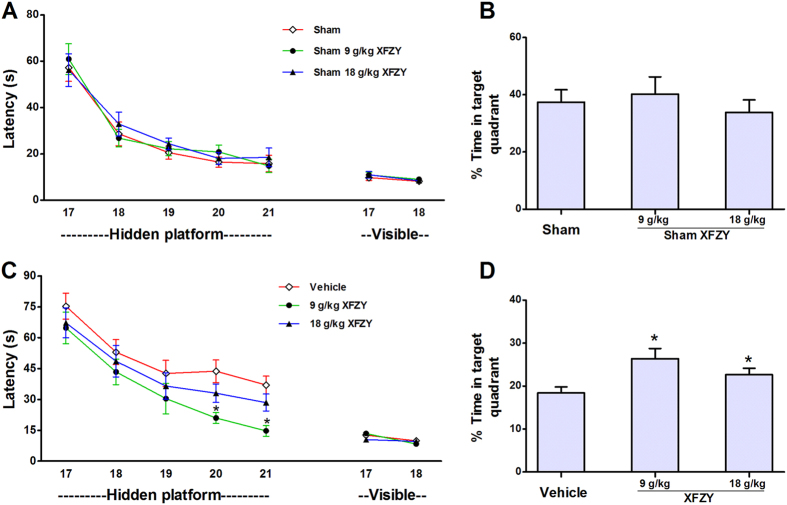
Effect of XFZY on cognitive outcomes after sham injury or controlled cortical impact (CCI).(A,B) Sham-injured rats (n = 8/group) were gavaged with 9 g/kg XFZY, 18 g/kg XFZY, or an equivalent amount of saline each day. The Morris water maze (MWM) test was then performed from the 17th to the 21st day after the sham injury. Performance in the MWM revealed no differences between the hidden and visible platform (p > 0.05 for group, repeated-measures ANOVA (RM ANOVA)) or in the probe trials (p > 0.05, B), despite learning the task (p < 0.01 for time, hidden and visible platform trials). (C, D) In the CCI groups (n = 12/group), significant group effects were observed in the hidden platform tests to assess the impact of XFZY treatment (p < 0.01 for the group) with learning the hidden platform paradigms (p < 0.01 for time in each group). The rats that were treated with 9 g/kg XFZY performed significantly better than the vehicle-treated mice in the hidden platform (p < 0.05) and probe trials (p < 0.05). Although there were no significant differences in the hidden platform test, the 18 g/kg XFZY group displayed significantly improved performance in the probe trials compared with the Vehicle group (p < 0.05). No differences in visible platform performance were noted among the CCI groups (p > 0.05 for group). *p < 0.05 versus the Vehicle group.